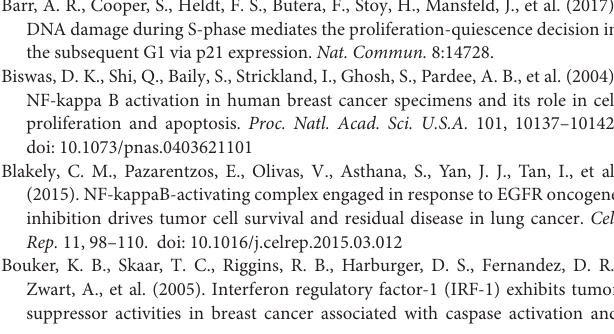
Supplementary Figure 1 | Overexpression of BCA2 does not accelerate cell migration. Cell migration was assessed in MCF-7, MDA-MB-231, and MCF-12F cells transfected with HA-GST or HA-BCA2 over the course of 48 h. When cells reached > 90% confluence, the monolayer was scratched, and cell migration was monitored by live cell imaging. Scale bar: 1,000 µ m. Supplementary Figure 2 | Depletion of BCA2 delays cell migration in non-tumor breast epithelial cells. Cell migration was assessed in MCF-7, MDA-MB-231, and MCF-12F cells stably transduced with shScrambled RNA or shRNAs specific for BCA2. BCA2 knockdown was verified by RT-qPCR on the day the cells were plated (not shown). When cells reached > 90% confluence, the monolayer was scratched, and cell migration was monitored by live cell imaging. Scale bar: 1,000 µ m. Supplementary Figure 3 | BCA2 has no effects on IRF1 protein stability. (A,B) HEK293T cells (A) and MCF-7 cells (B) were transfected with HA-BCA2 or HA-GST (irrelevant proteins). 48 h later, cells were treated with DMSO or 200 µ M of CHX for 10 h. Cells were harvested at 0, 4, and 10 h after CHX treatment. The relative levels of IRF1 are displayed underneath the blots, after correcting with β -actin levels. Blots are representative of 3 independent experiments. Red pound symbol: unspecific bands